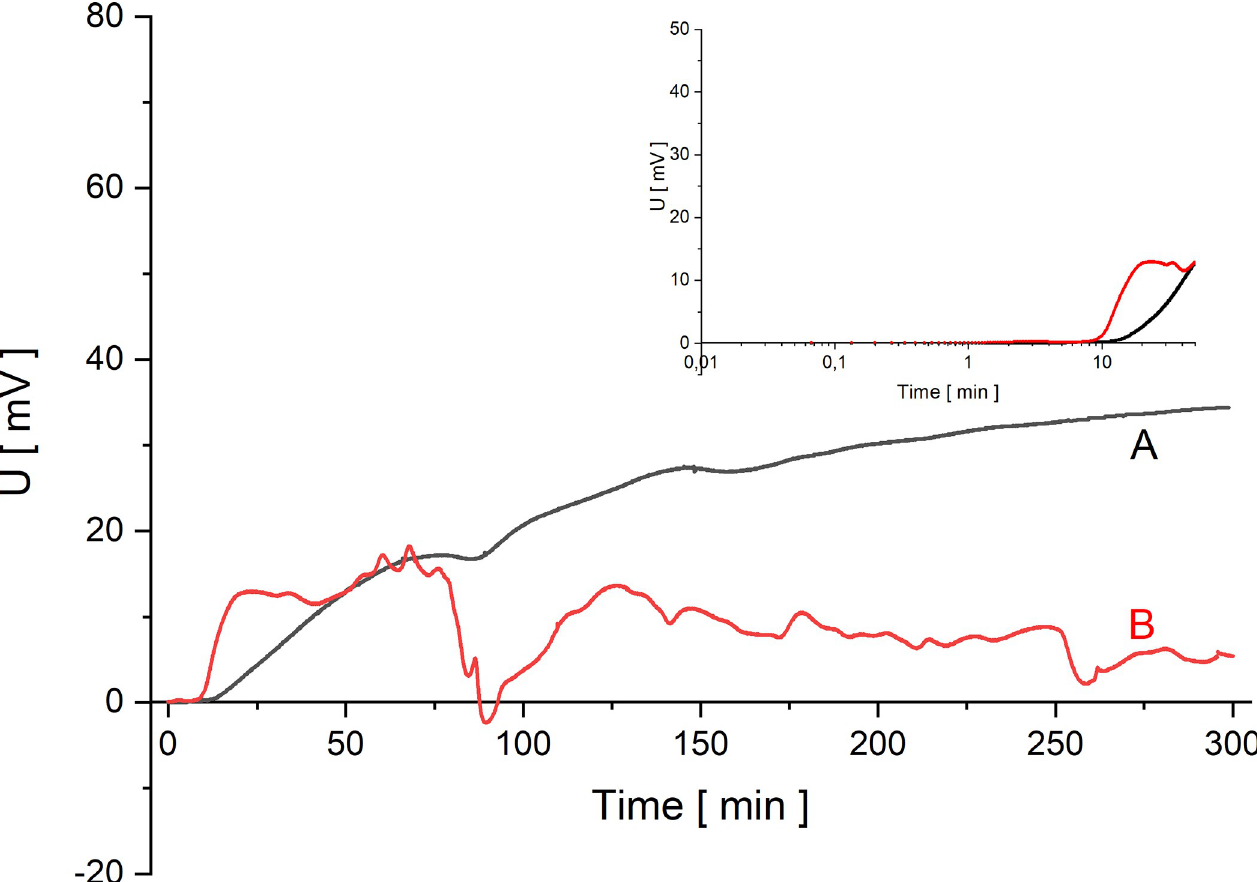
Fig 2. Voltage between electrodesin the chamberwith lower concentration as a functionof time for configurations A (black) and B (red) and for C h / C l = 100.